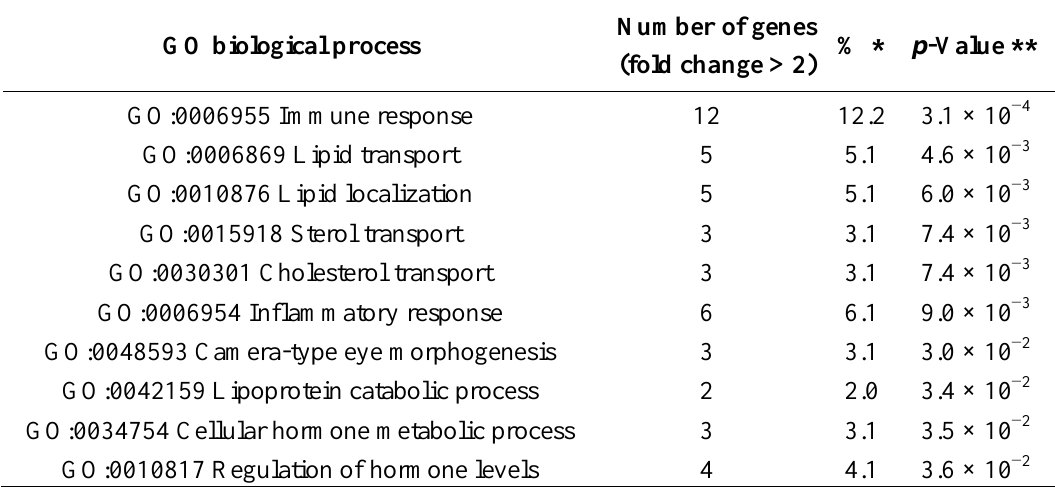
Table 4. Functional categories of genes differentially regulated by both DSS and